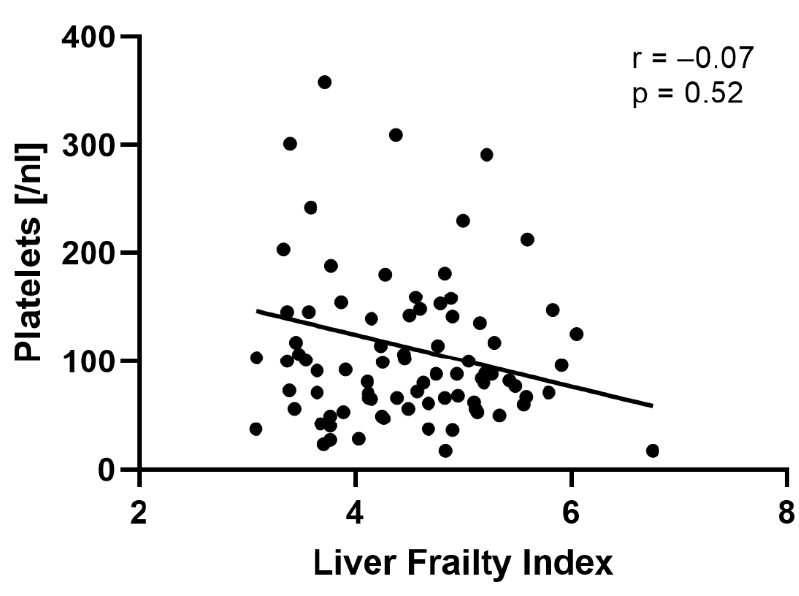
Figure 2. Correlation between MELD, albumin, platelets and the liver frailty index.